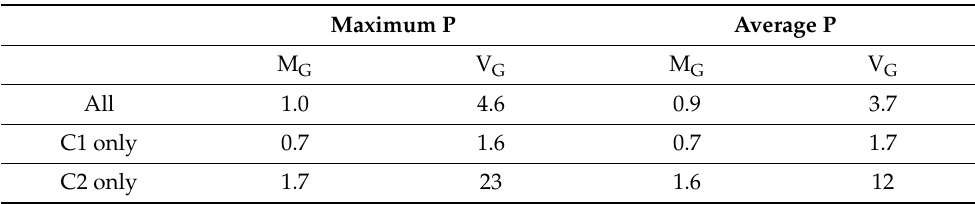
Table 3. Cloud located at locations conducive to generating high overpressures: Geometric Mean and Variance. Maximum P column taken from [2].